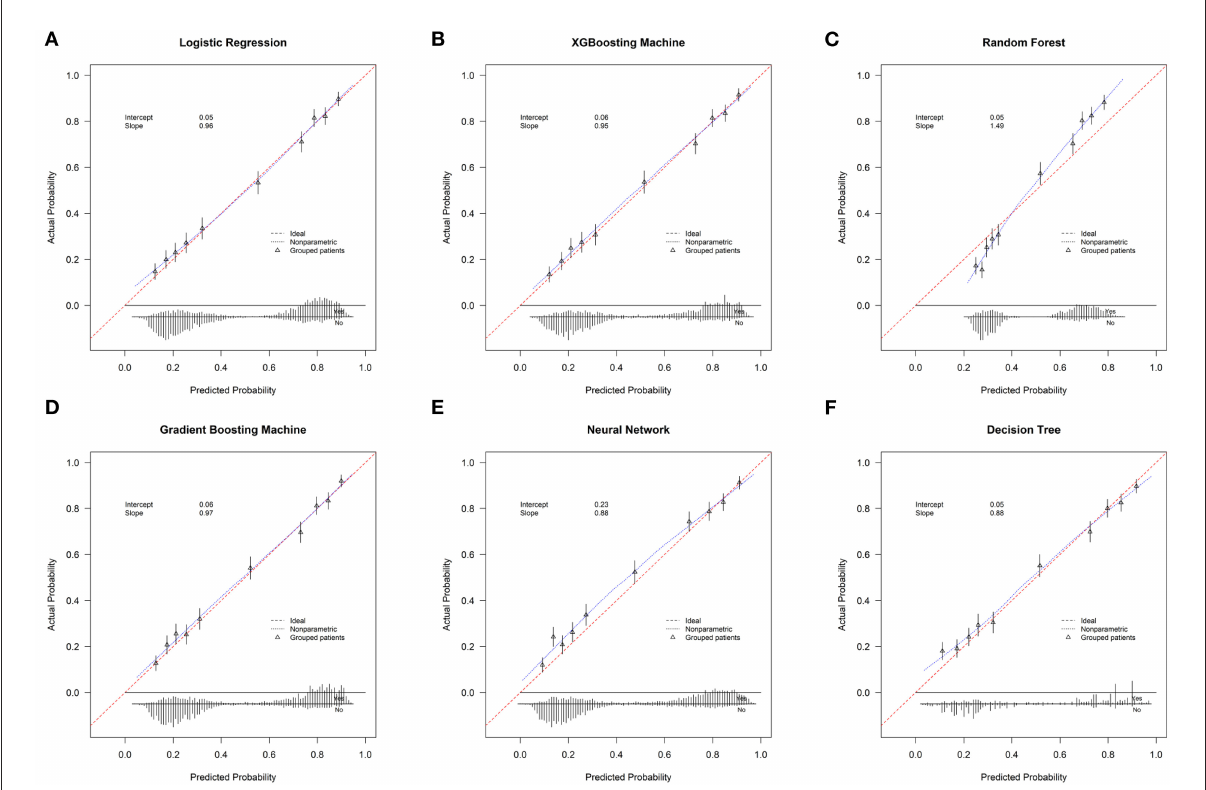
FIGURE2 The calibration curves. (A) Logistic Regression; (B) XGBooting Machine; (C) Random Forest; (D) Gradient Boosting Machine; (E) Neural Network; (F) Decision